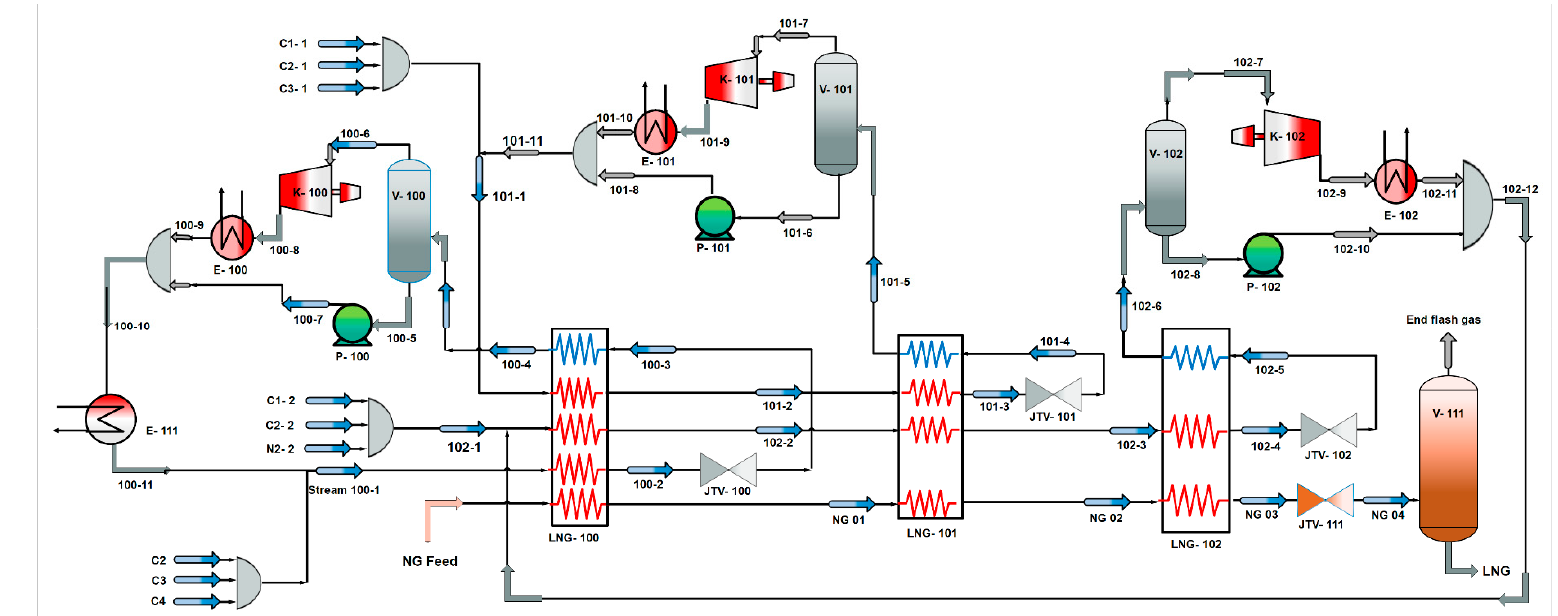
Figure 3. Schematic representation of MFC–LNG process